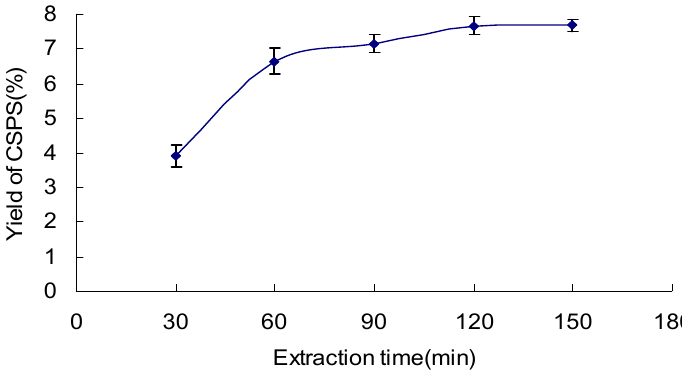
Figure 2. Effect of extraction time on the yield of CSPS under extraction temperature 90 °C, ratio of water to sample 10 mL/g, and extraction cycle 1.